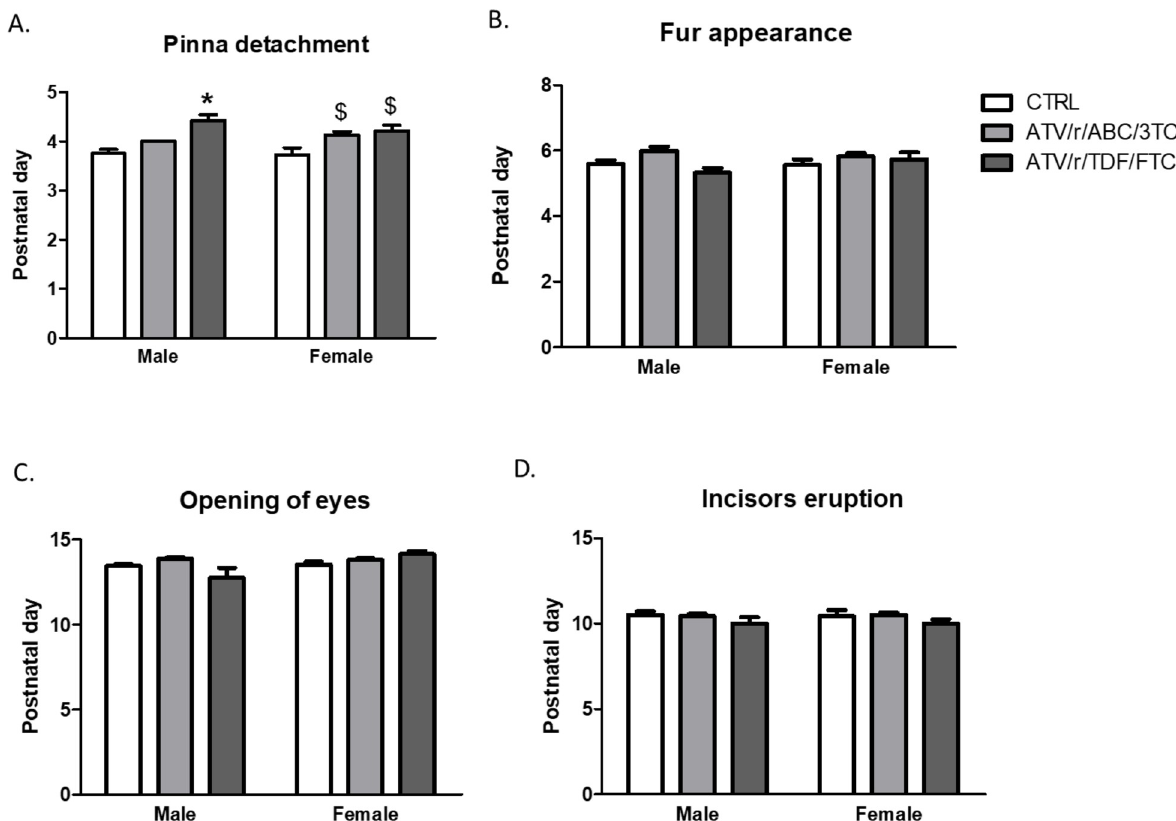
Fig 3. In-utero exposure to ART delays somatic development. Postnatal day of pinna detachment (A), fur appearance (B), eye opening (C), incisor eruption (D) for male and female pups exposed in-utero to control (CTRL, white bars), ATV/r/ABC/3TC (light grey bars), or ATV/r/TDF/ FTC (dark grey bars). Data are mean ± SEM (n = 11–34 pups/group). A mixed effects model was used to examine differences between control and treatment arms (fixed effect) accounting for litter effects (random effect) stratified by sex. � p < 0.05 compared to control males. $ p < 0.05 compared to control females. ATV/r, ritonavir-boosted atazanavir; ABC, abacavir; 3TC, lamivudine; TDF, tenofovir; FTC, emtricitabine; CTRL,